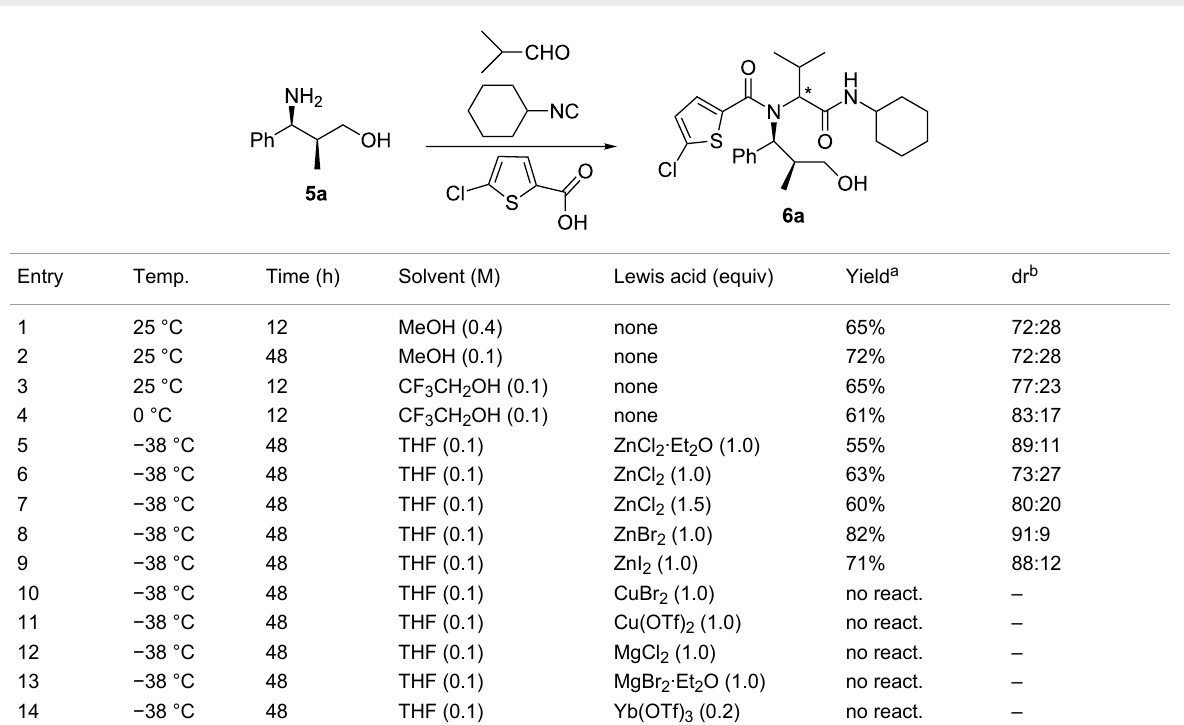
Table 1: Optimization of the synthesis of 6a